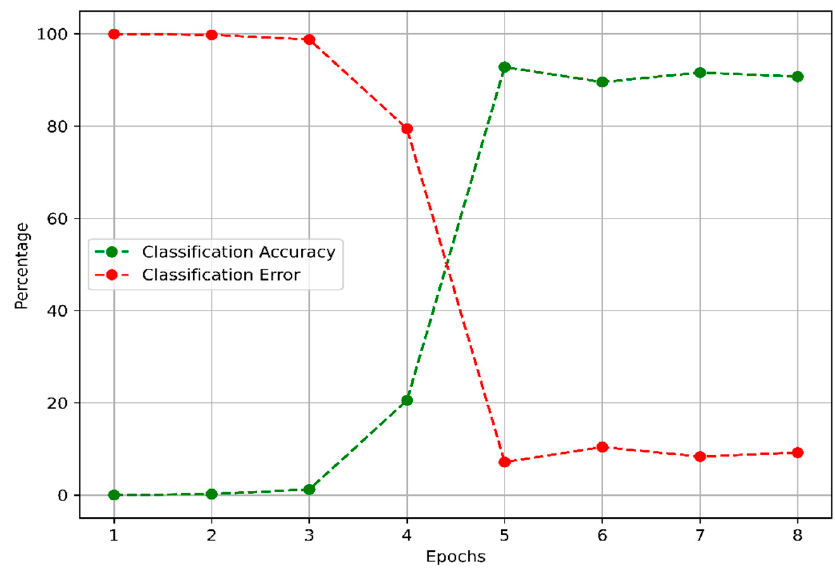
Figure 11. Accuracy of DLCC model to classify MovieLens dataset on the basis of popularity.